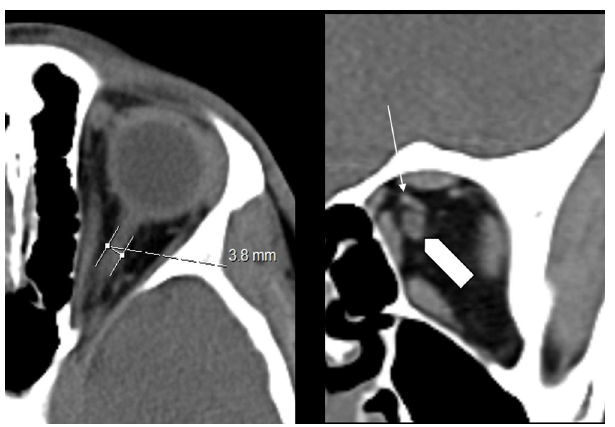
Fig 2. ONSD measurements. A. The measurement of the optic nerve sheath diameter on axial noncontrast CT scan at a point where the ophthalmic vein (thin white arrow) crosses the optic nerve (thick white arrow). B. Coronal images used as reference. The white arrow shows the ophthalmic vein crossing the optic nerve.